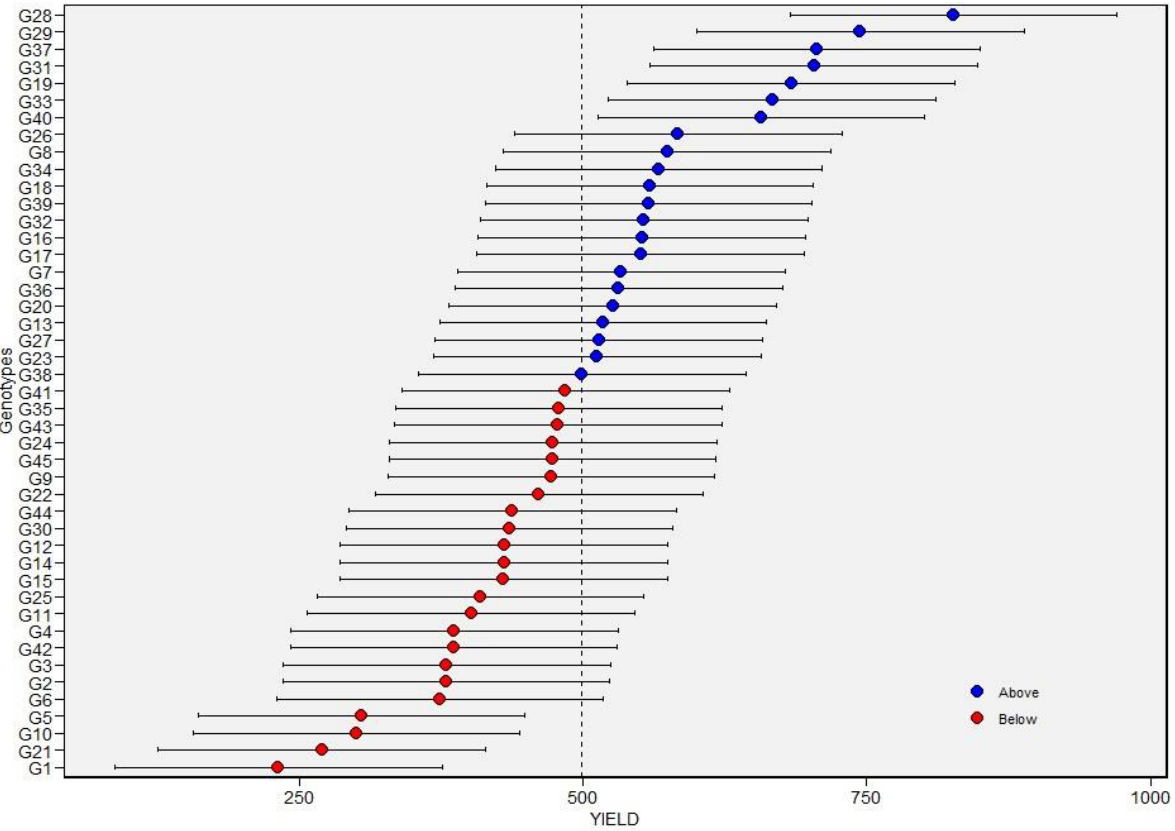
and 82 days and 77 days in season 2, respectively. The overall mean for DTM was 79.98